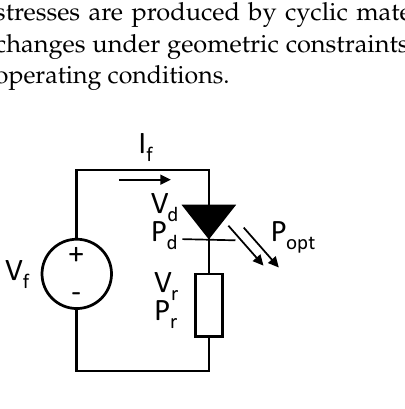
Figure 2. Schematic diagram of the LED electrical